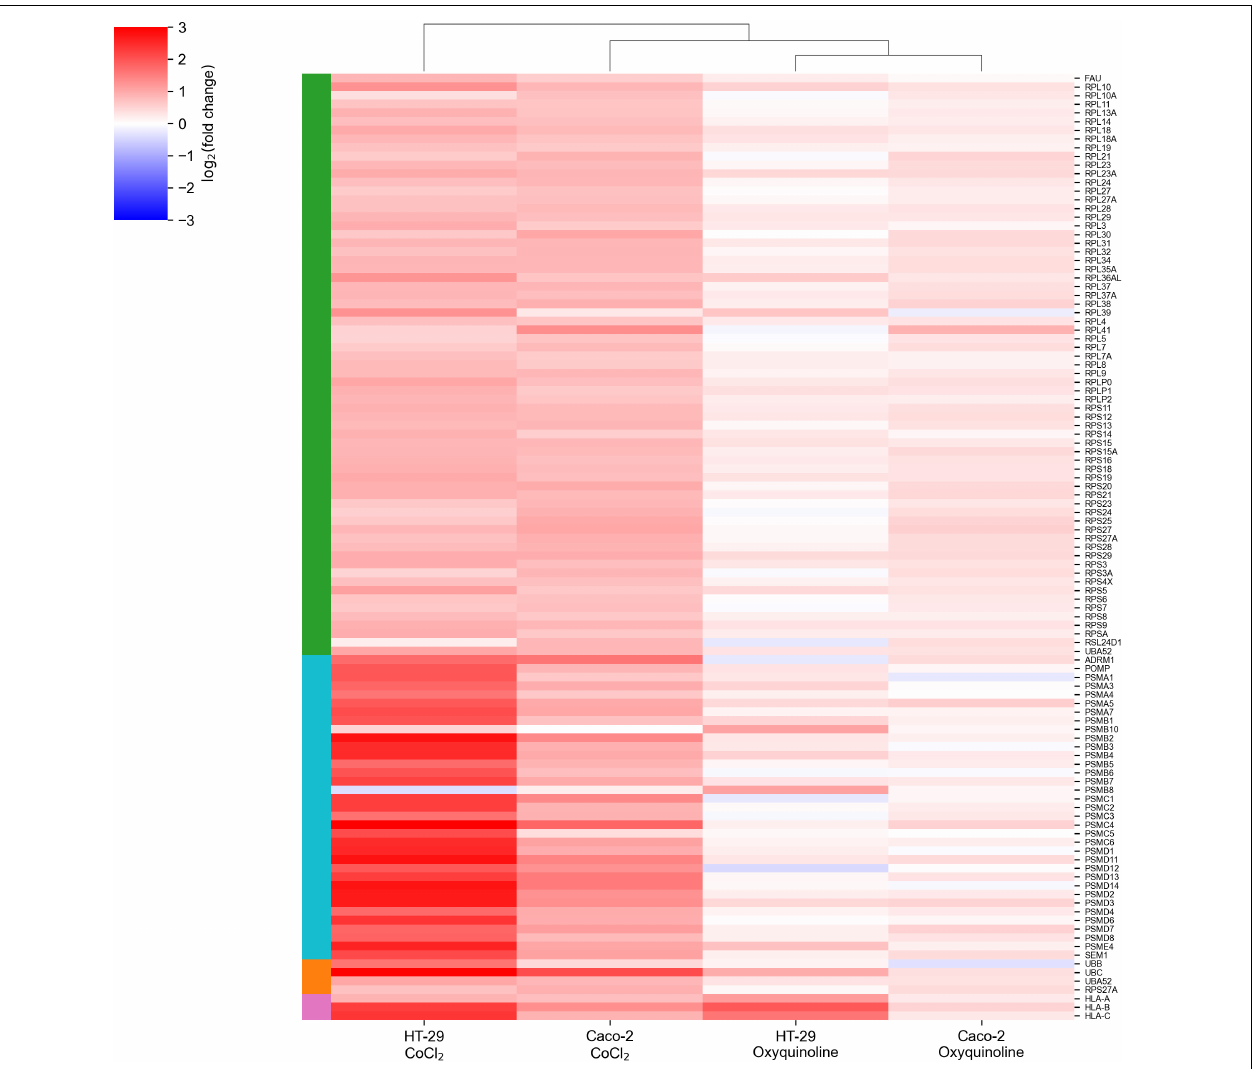
FIGURE 2 | CoCl 2 -specific upregulation of gene groups. The green-, cyan-, orange-, and pink-colored rows are associated with ribosomal subunits, proteasome subunits, ubiquitin, and MHC class I molecules, respectively.